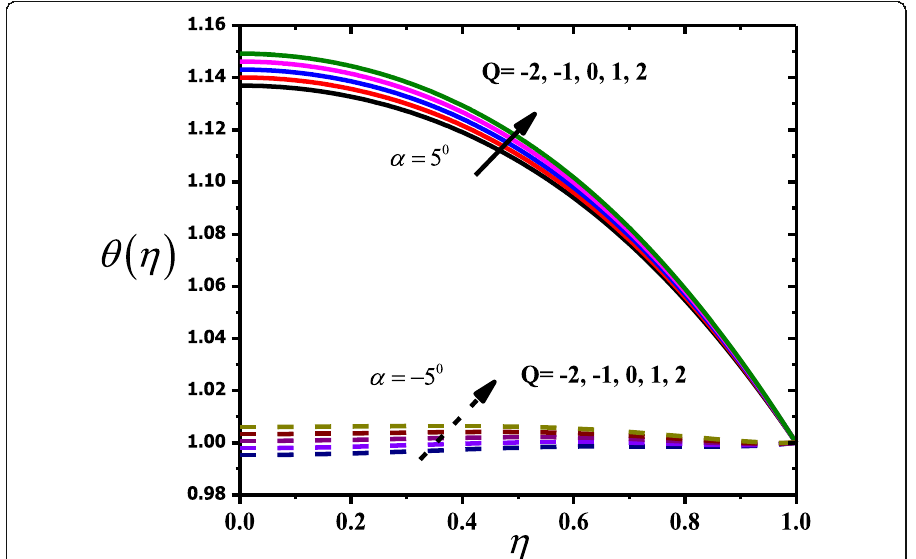
Fig. 12 Temperature vs. Q in stretching divergent and shrinking convergent channels